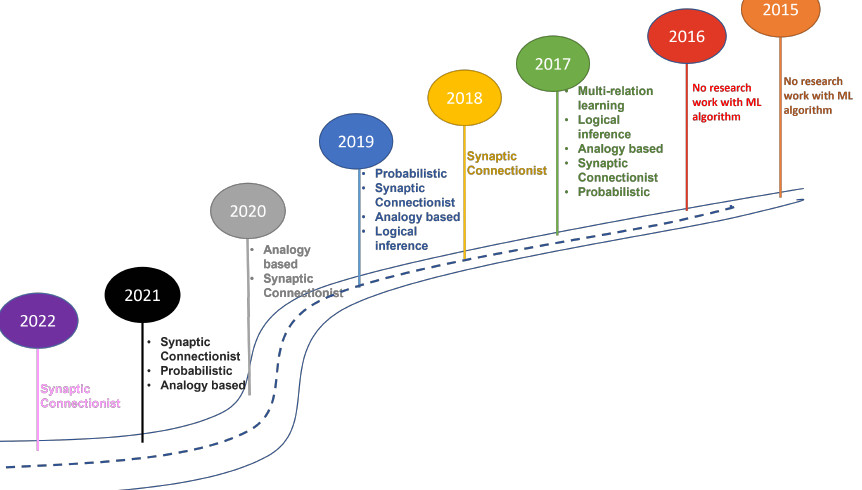
Figure 12. Summary of ML Algorithm over time.